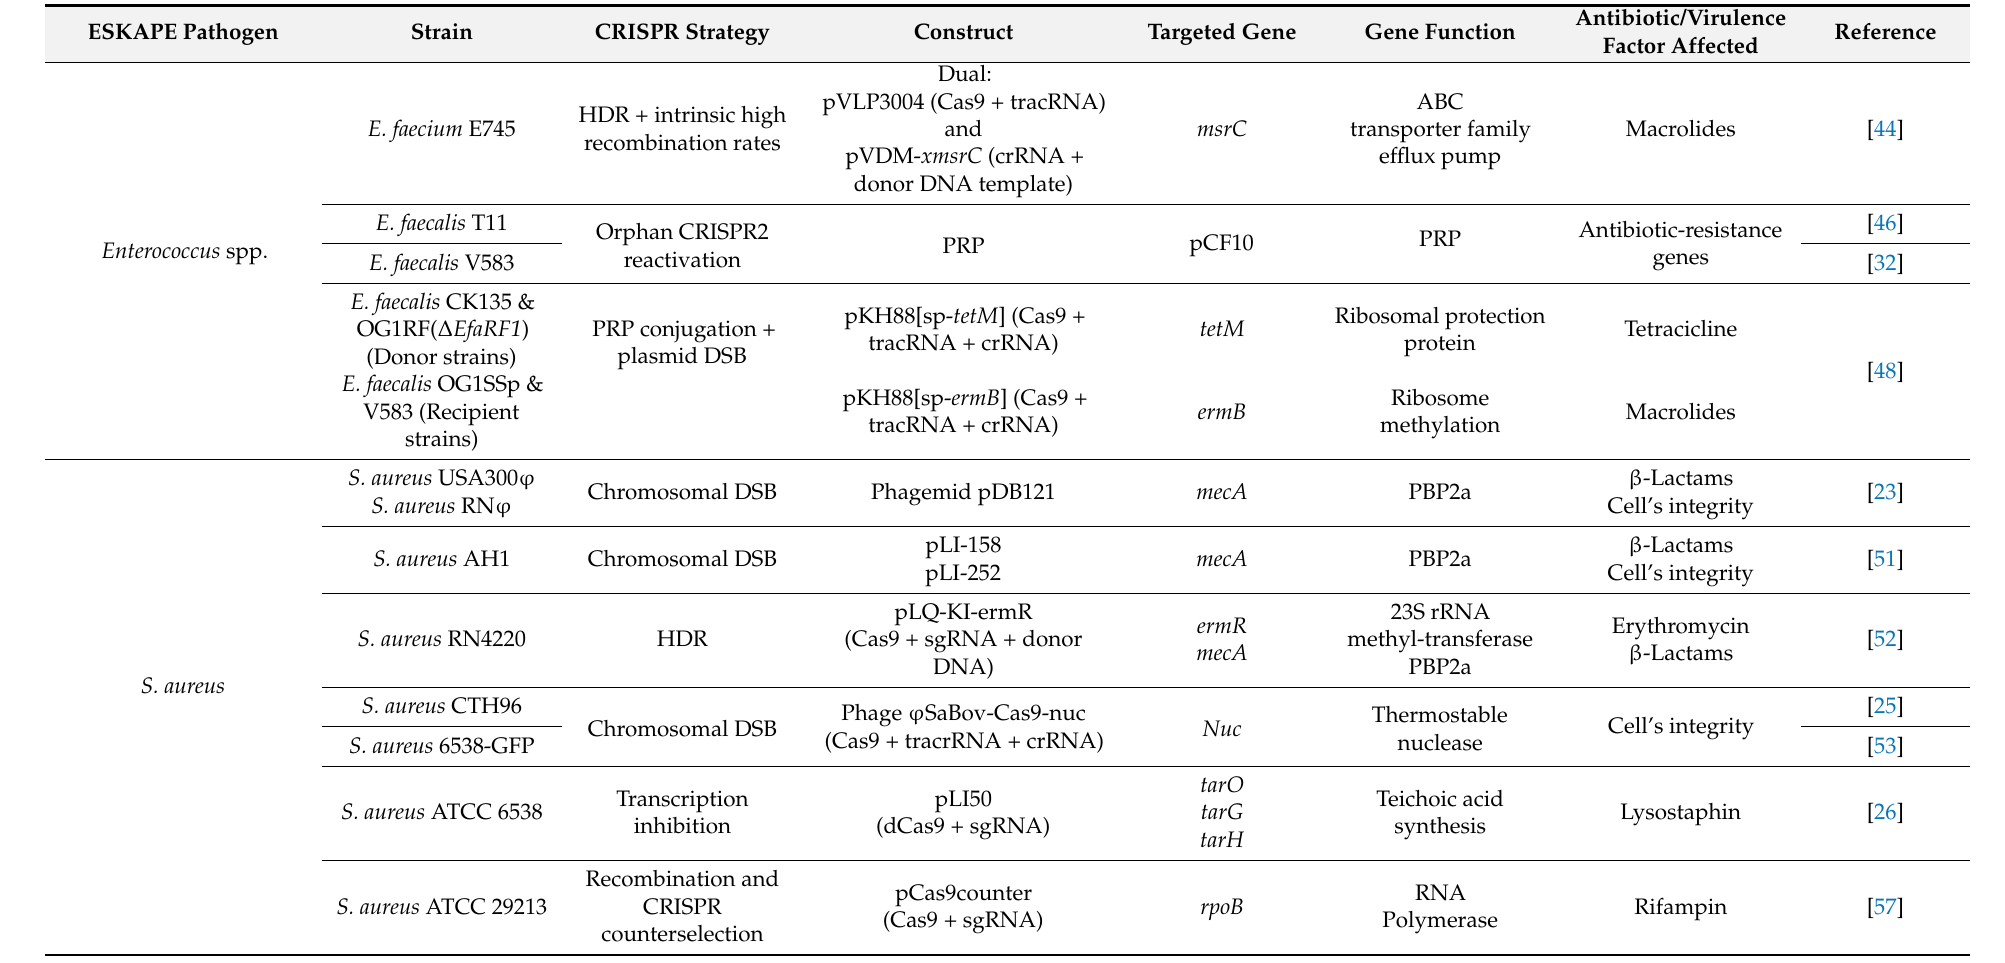
Table 1. Summary of the CRISPR-Cas strategies used in the treatment and study of the molecular mechanisms of AMR in bacteria belonging to the ESKAPE group. ESKAPE Pathogen